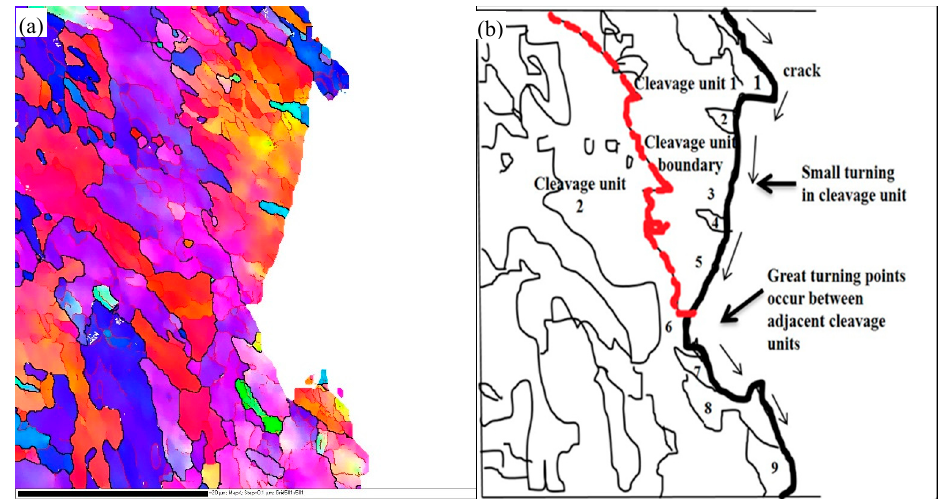
Figure 15. Orientation and schematic map of DWTT crack propagation: ( a )orientation map of DWTT crack propagation, ( b ) schematic map of DWTT crack propagation according to Figure 15a.